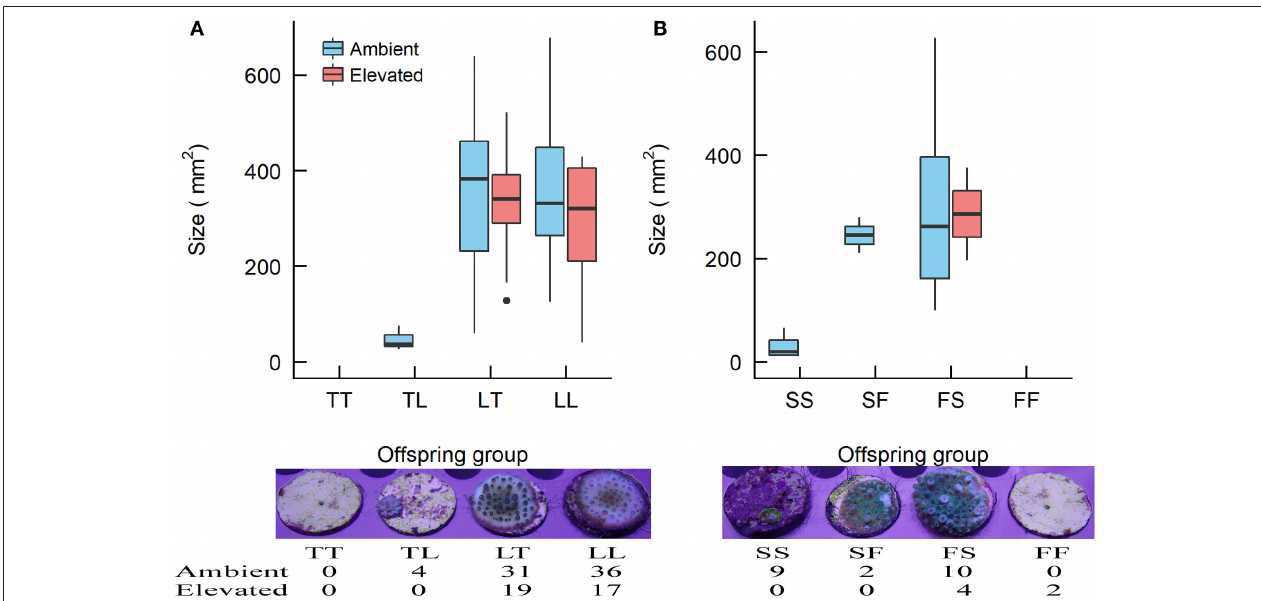
FIGURE 6 | Boxplots showing the size of the Acropora offspring groups at 1 year of age (i.e., ∼ 5 month since relocation to long-term grow-out tank under raw ambient seawater. (A) The Acropora tenuis (T) × Acropora loripes (L) cross and (B) the Acropora sarmentosa (S) × Acropora florida (F) cross. The first letter of the offspring groups’ abbreviation represents the origin of the eggs and the second letter the origin of sperm. Where no data are presented there were no survivors in that offspring group. The horizontal bars indicate the medians, box length indicates the interquartile range, and the small circles indicate unusual points. Images below the graphs show examples of median size recruits of the offspring groups reared under ambient conditions in the experiment, and the number of survivors of each offspring group.